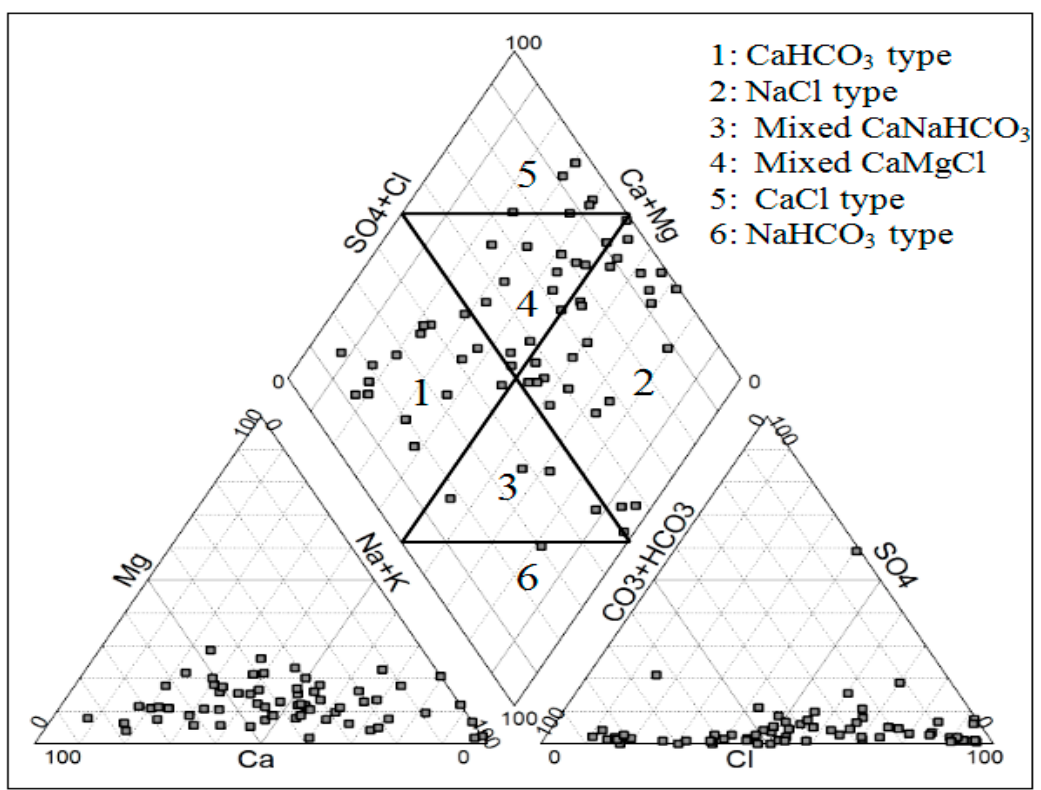
Figure 5. Piper plot of the groundwater chemistry in May 2012. Water 2018 , 10 , x FOR PEER REVIEW